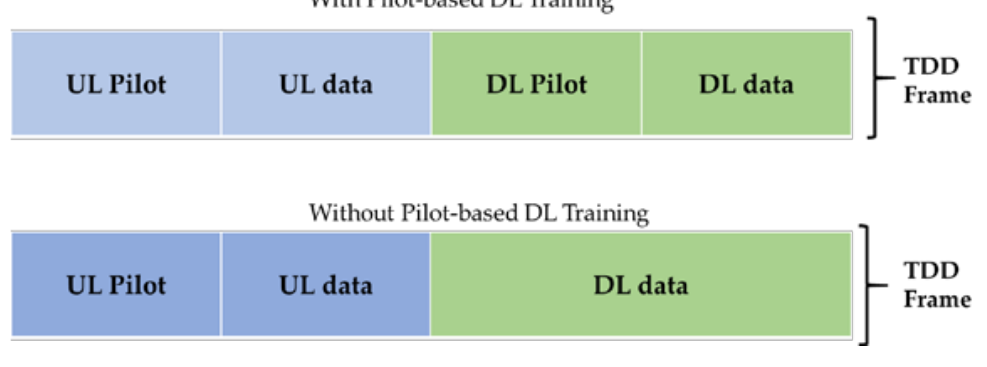
Figure 5. With and without pilot-based DL training.